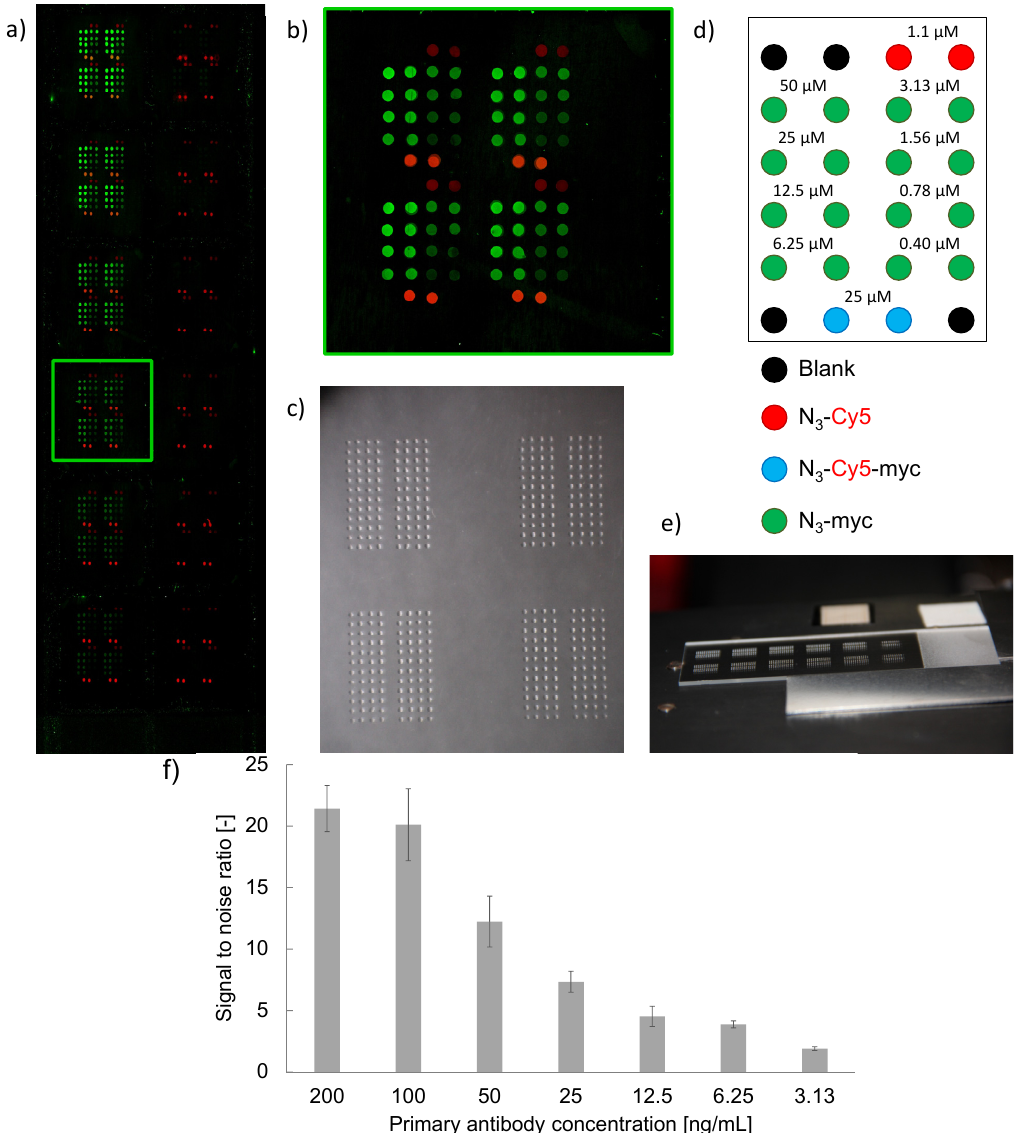
Figure 6. Image of anti- myc antibody titration experiment with 1 nL of N deposited at concentrations according to the layout in ( d ) and probed with anti- myc -peptide mAb in a 1152-spot array at concentrations of 200, 100, 50, 25, 12.5, 6.25, 3.13, 1.56, 0.78, 0.39, 0.2 and 0.1 ng/mL ( a , top to bottom, left to right). ( b ) sub-array image at an anti- myc mAb concentration of 25 ng/mL. ( c ) microscopy image of slide section with droplets, ( e ) photo of spotted glass slide with 12 sub-arrays visible. ( f ) Signal-to-noise (background) ratios (SNR) for spots at a deposited peptide concentration of 25µM and anti- myc mAb concentrations above the LOD, i.e. between 200 and 3.13 ng/mL. Spot diameter (mean value, SD) = 273 ± 20 μ m (n = 64 spots); spot homogeneities, CV = 18% (n = 64 spots); noise (background) intensity (mean value, SD) = 441 ± 116